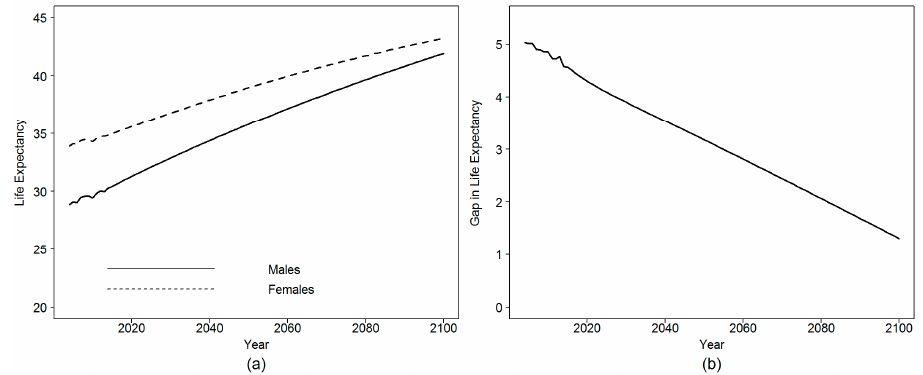
Figure 16 . Projected life expectancy at age 50 for the retired population: ( a ) the time evolution of the life expectancy at age 50 for retired males and females; and ( b ) the sex gap in life expectancy and its expected time evolution.